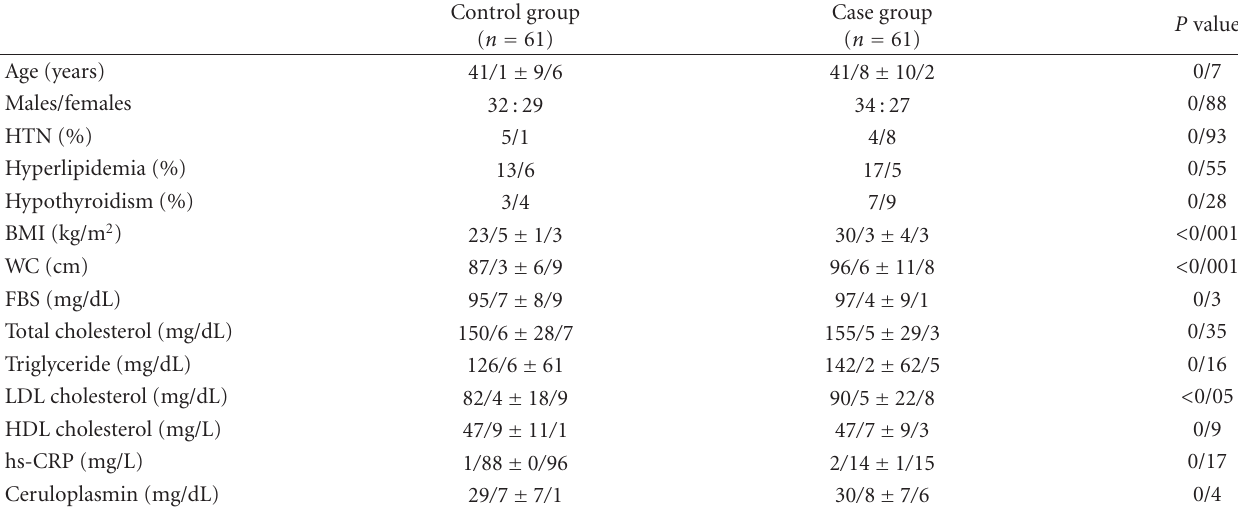
Table 1: Baseline and serum characteristics of study subjects. Data are presented as means ± SD.